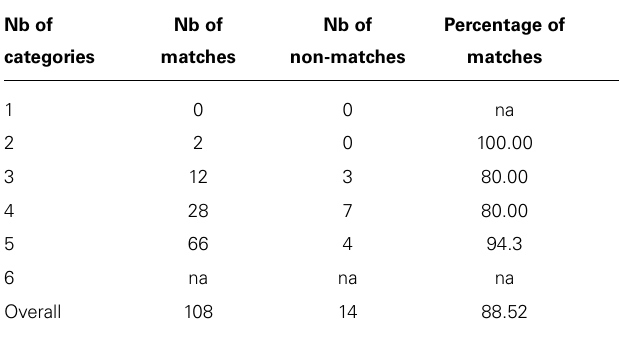
Table 2 | Correspondence between the emotion categories used by the participants and the sequence proposed byWiden and Russell